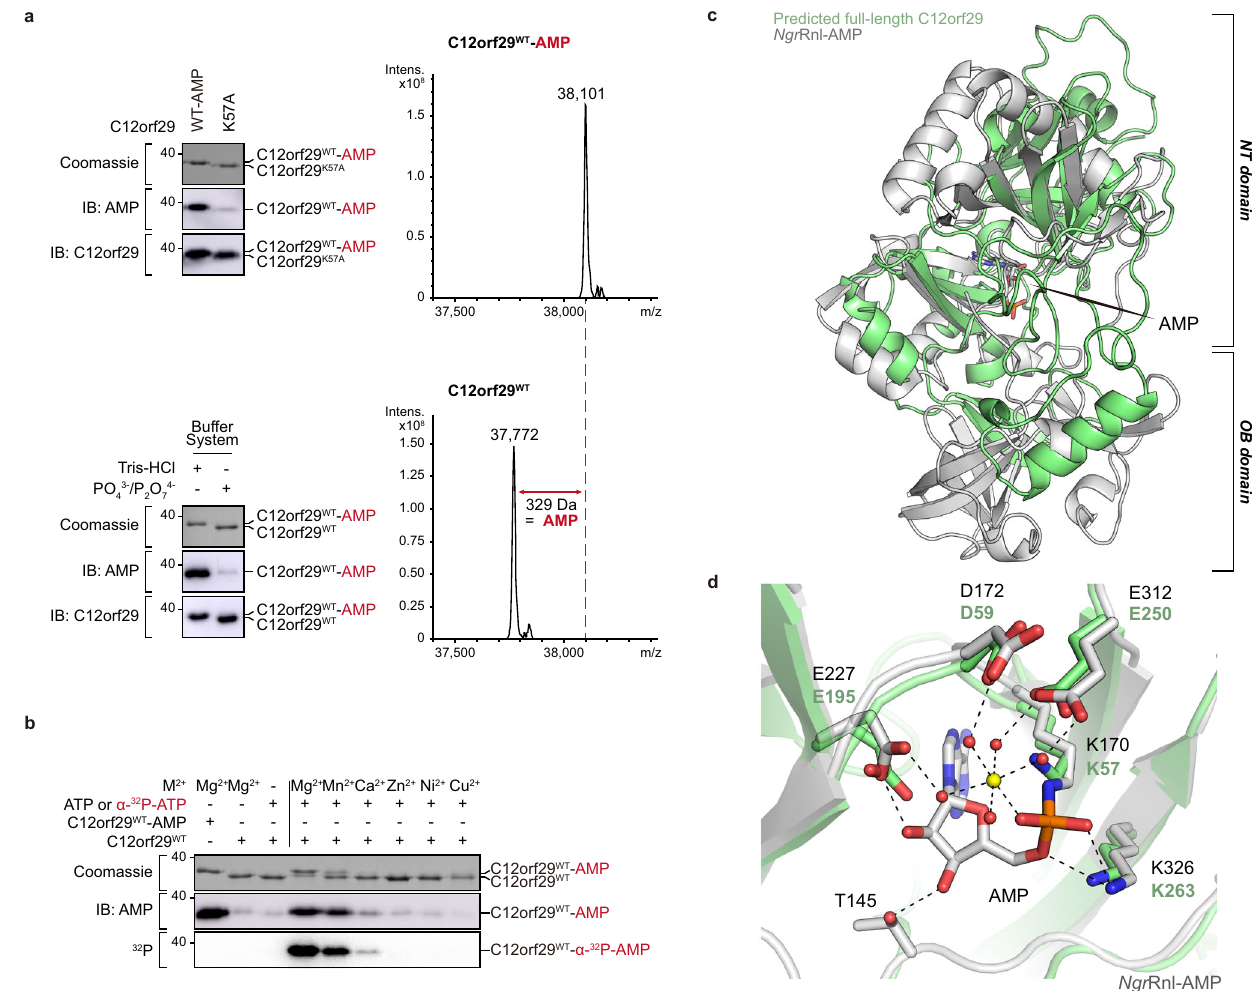
Fig.2|Auto-AMPylationactivityandstructuralpredictionofC12orf29.a (Top) immunoblotting of C12orf29 WT -AMP and C12orf29 K57A and LC-MS analysis of C12orf29 WT -AMP. C12orf29 K57A is de fi cient in auto-AMPylation activity (representa- tive images of n = 3). Mass spectraindicating a 329 Daincrease in mass upon auto- AMPylation of C12orf29 WT . C12orf29 WT -AMP: calc. 38,100 Da, found 38,101 Da. C12orf29 WT : calc. 37,771 Da, found 37,772 Da. (Bottom) preparation of C12orf29 WT andC12orf29 WT -AMPwithdifferentbuffersystems(representativeimagesof n =3). b Divalent metal ion dependency of auto-AMPylation activity of C12orf29 WT . c Superimposition of the structure of C12orf29 predicted by AlphaFold (green) 31,51 onthestructureof Ngr Rnl-AMP(PDBID:5COT,grey).OB,oligonucleotide-binding.